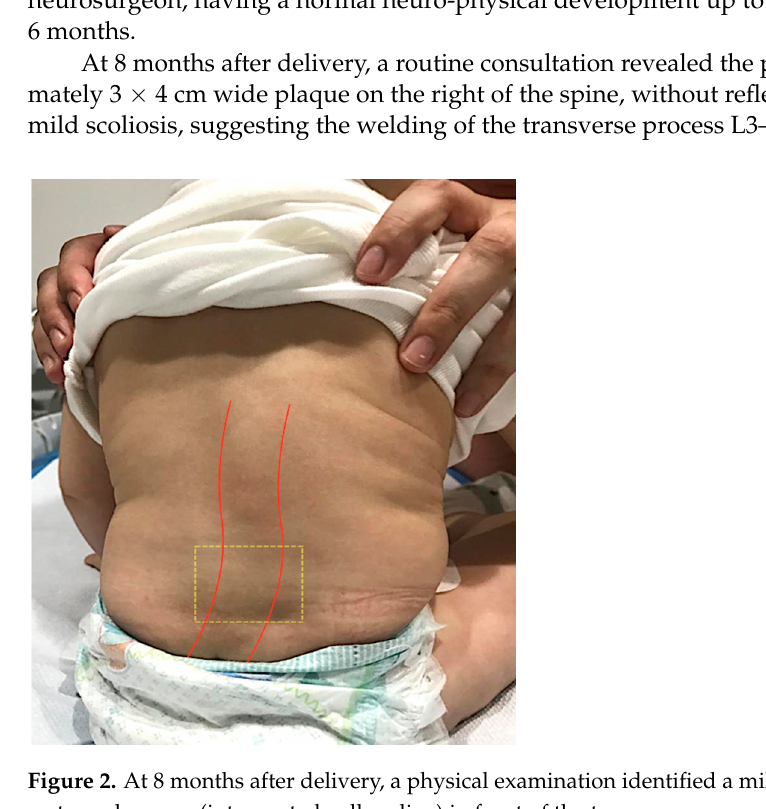
Figure 2. At 8 months after delivery, a physical examination identified a mild scoliosis (red line) and rectangular zone (interrupted yellow line) in front of the transverse process L3–L4.